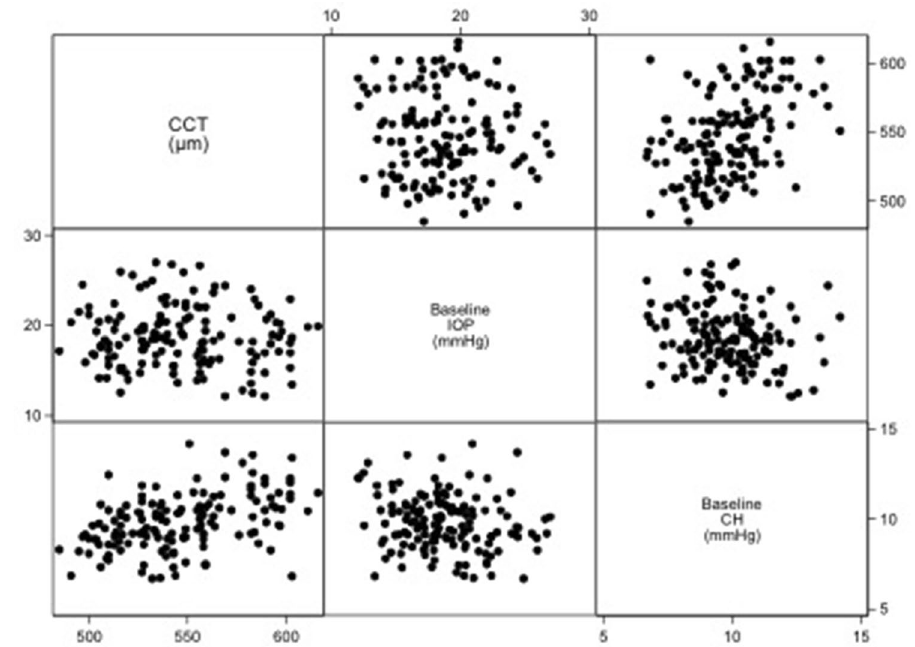
Figure 1. Scatter matrix illustrating the relationship among baseline corneal hysteresis (CH), central corneal thickness (CCT), and baseline dynamic contour tonometry (DCT) measurements (DCT-IOP).